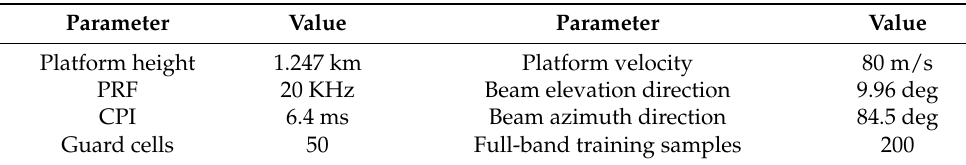
Table 3. Parameters of Radar